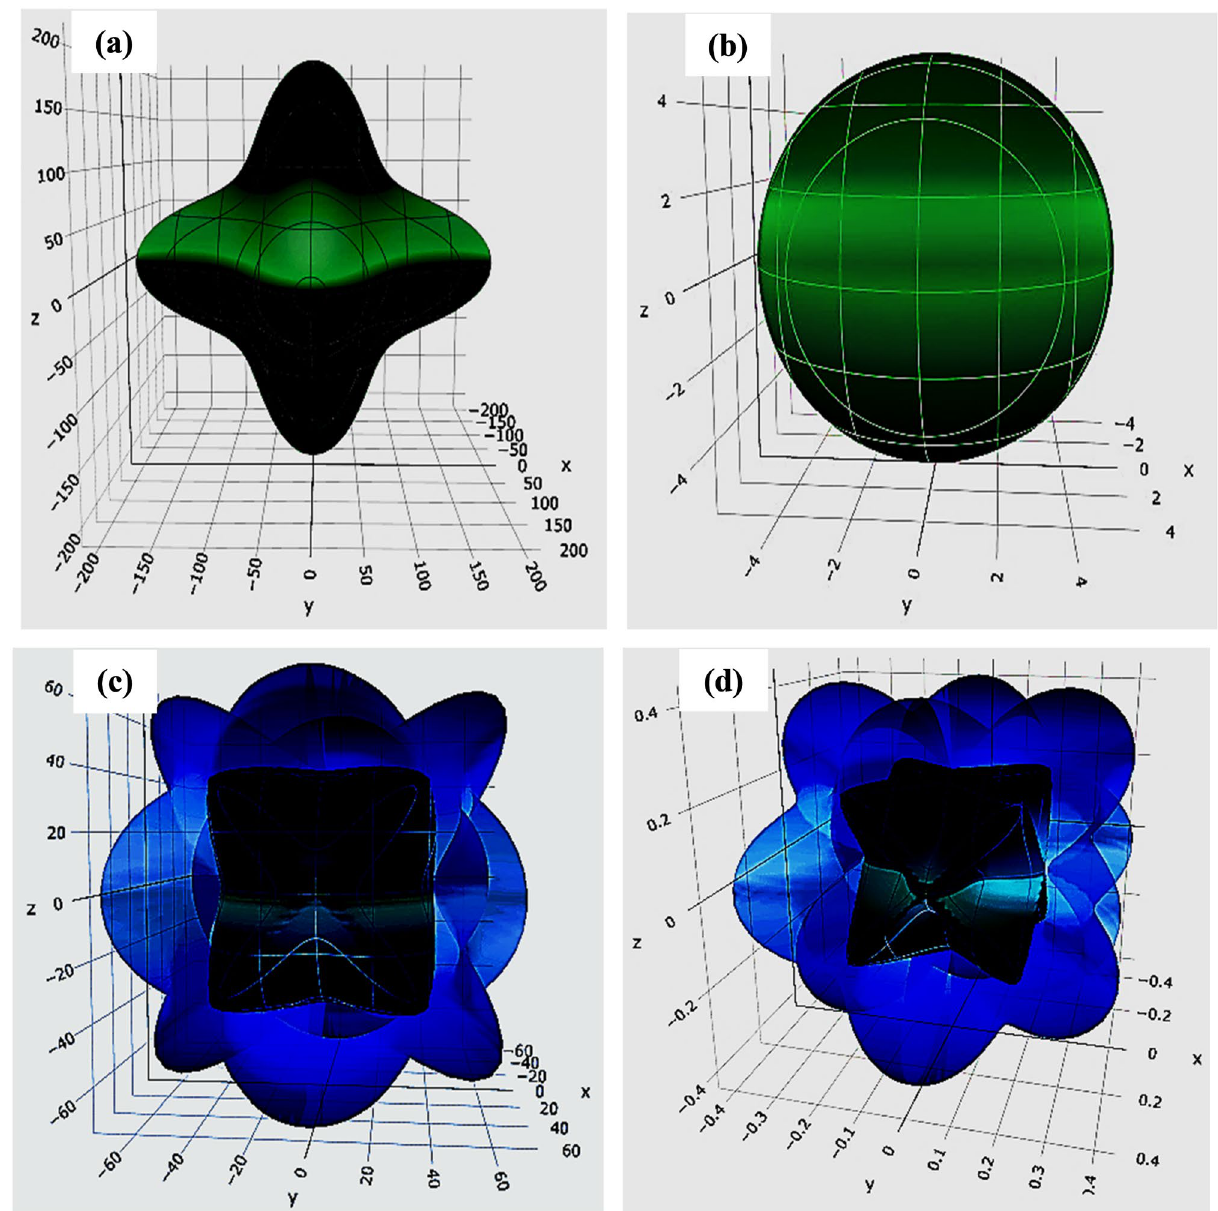
Figure 10. Three-dimensional graphics of ( a ) Young’s modulus ( Y ), ( b ) linear compressibility (β), ( c ) shear modulus( G ), and ( d ) Poisson’s ratio( v ) for RbNpO 3